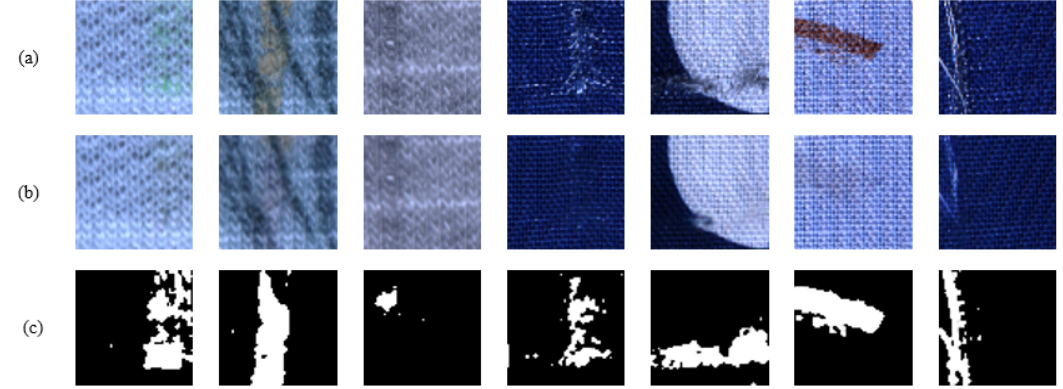
Figure 4. Samples of the outputs of the convolutional autoencoders: ( a ) defected fabric sample images, ( b ) reconstructed images from convolutional autoencoder, and ( c ) results of the proposed system.